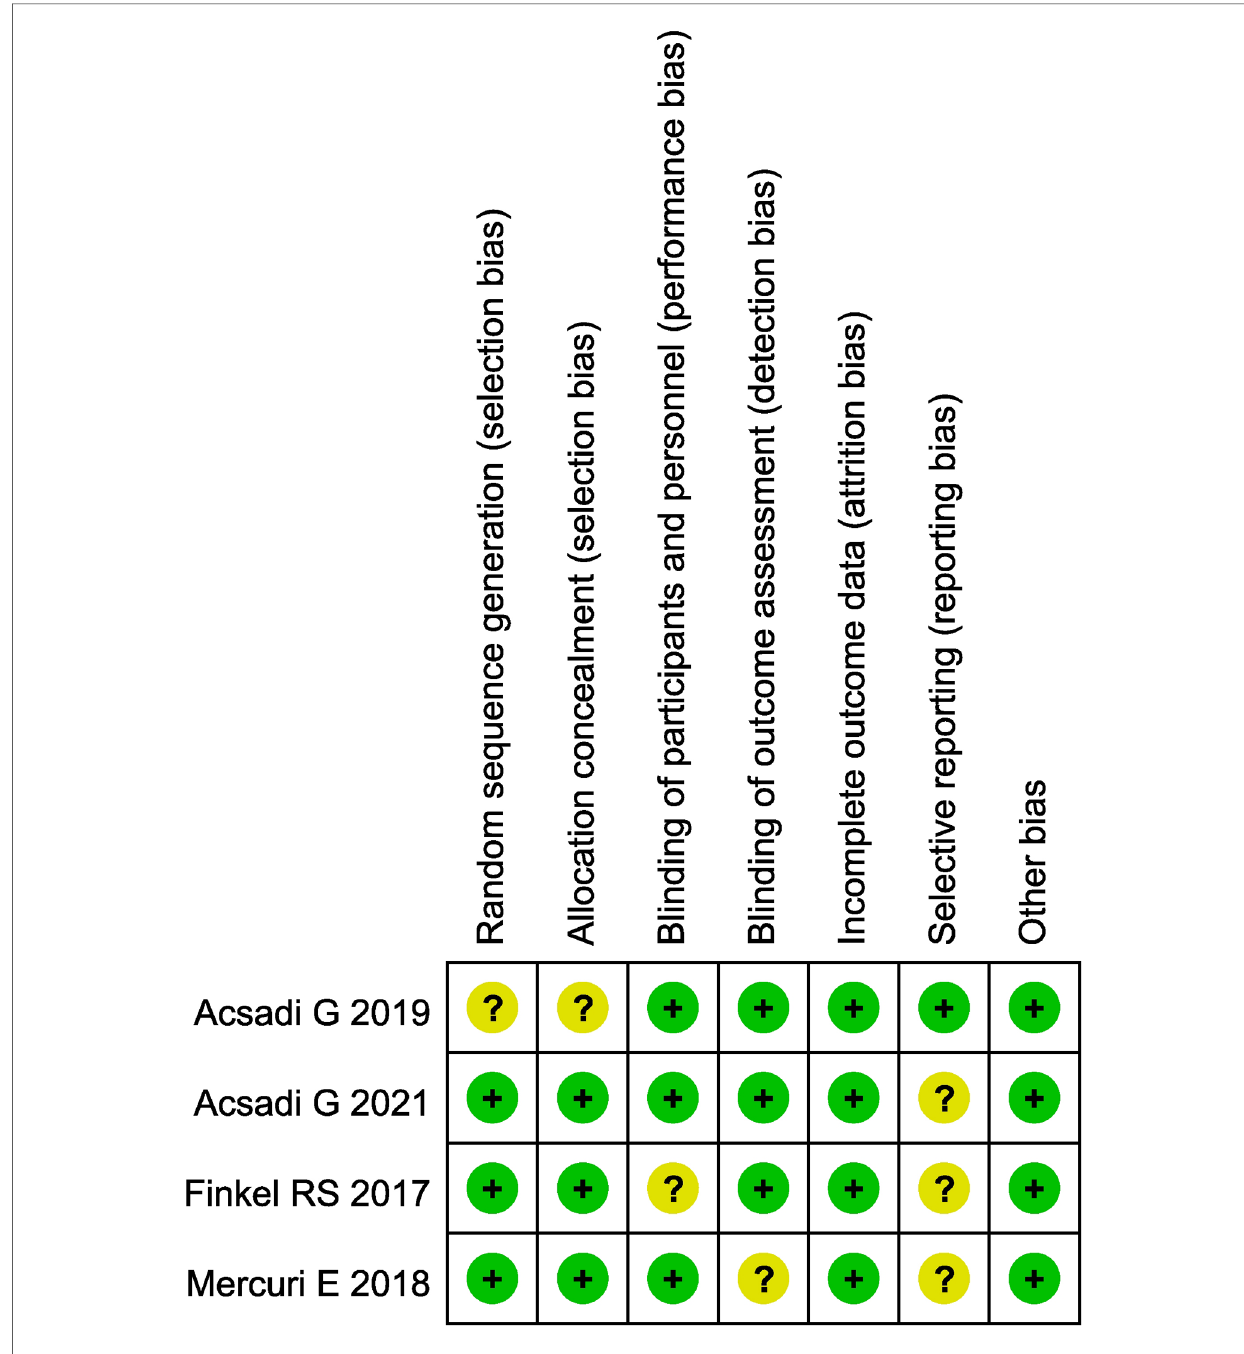
FIGURE 2 Evaluation of the quality of included randomized controlled